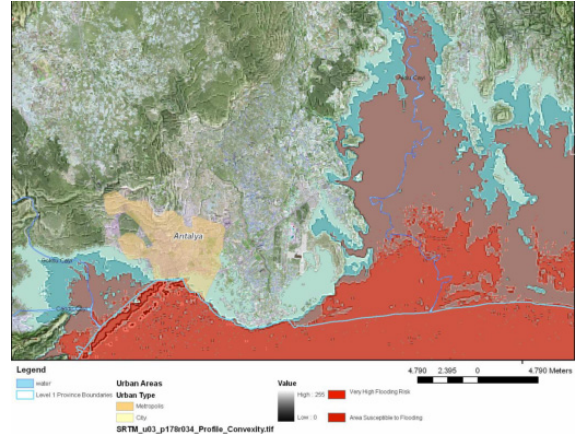
Figure 2 b. Proposed standard approach for the analysis causal factors in a GIS